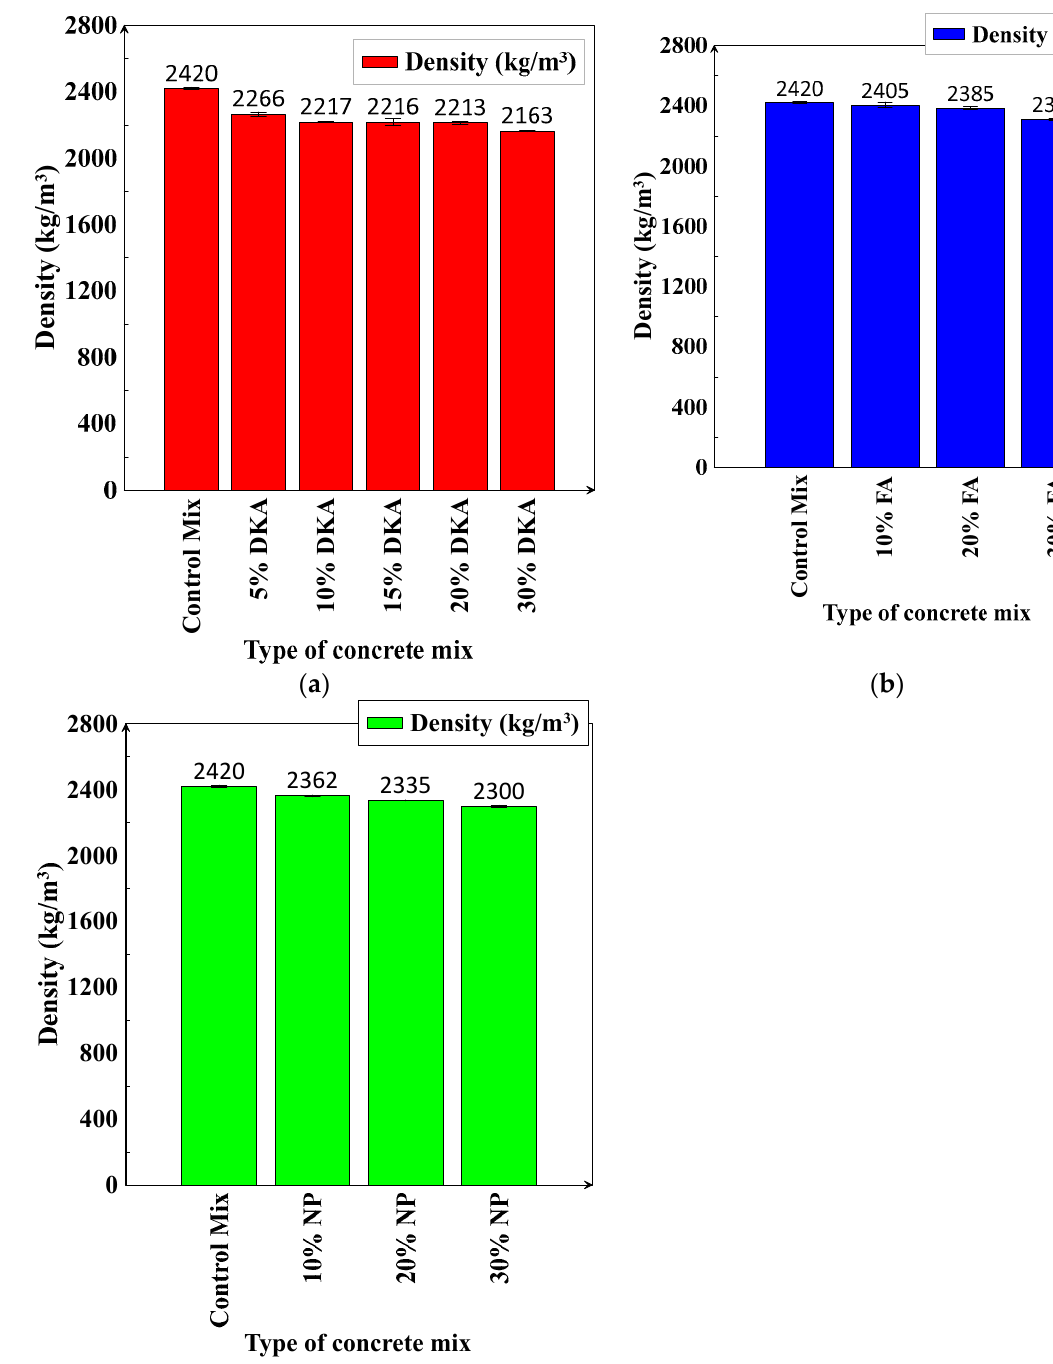
Figure 15. Density of concrete mixes containing ( a ) DKA, ( b ) FA, and ( c ) NP.